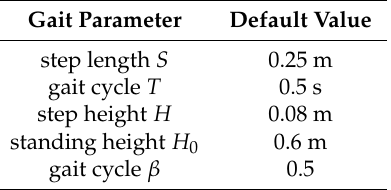
Figure 9. The flow chart of the simulation. Table 4. The default values of the gait